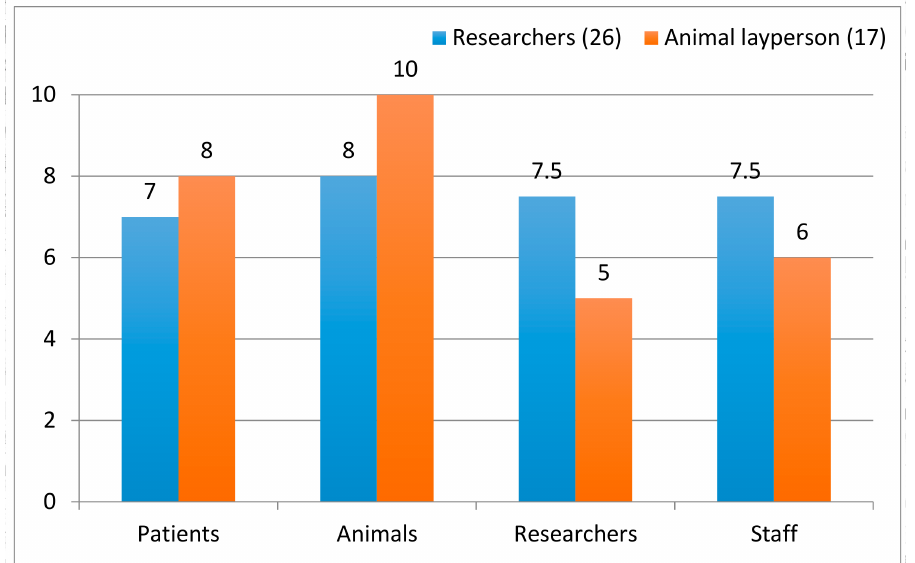
Figure 4. Researchers’ and animal layperson members’ combined median scores for statements in question 23 aiming to capture emotional and cognitive empathy for patients, animals, researchers and animal care staff. For every stakeholder two questions were included and scored from 1 (completely disagree) to 5 (completely agree), yielding a total maximum score of